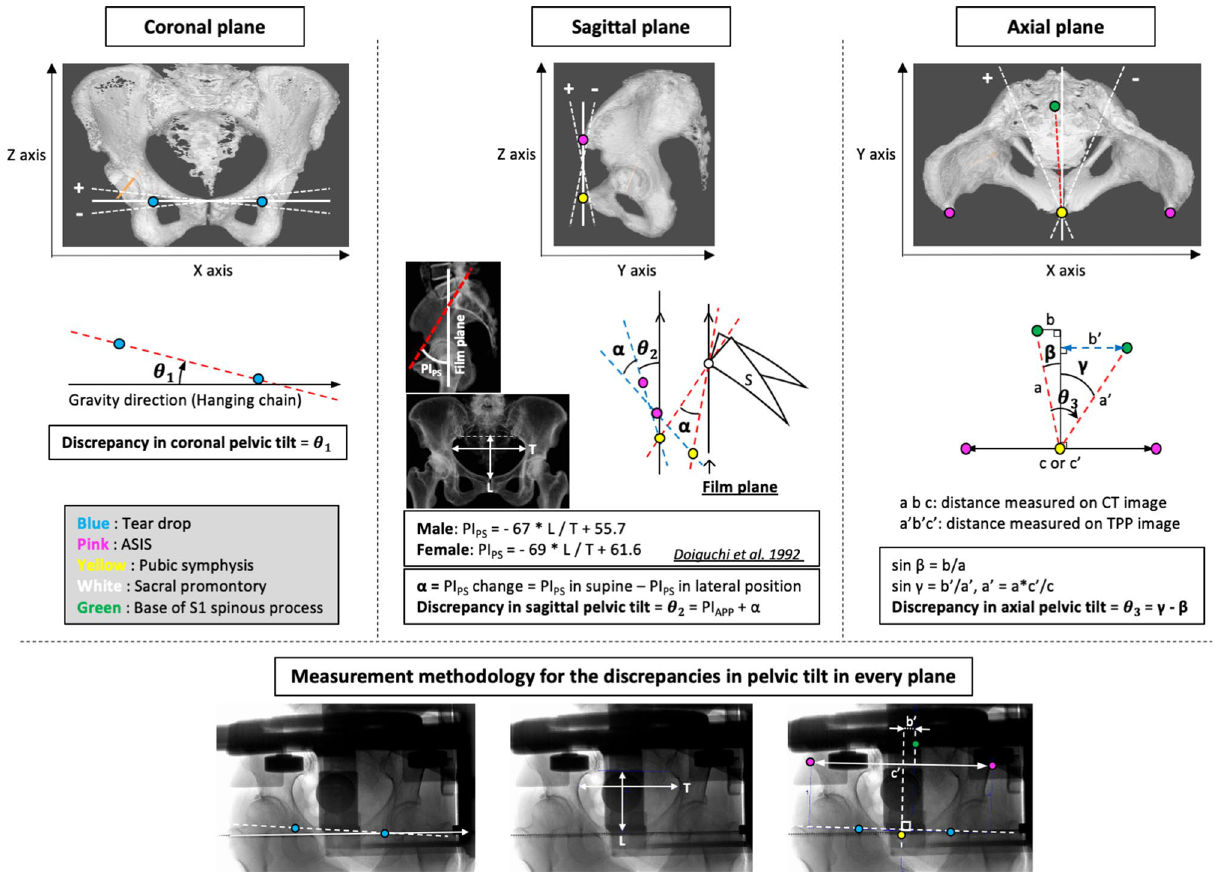
Figure 1. Measurement methodology for the discrepancies in pelvic tilt in every plane. When the operative side was on the right, the leftward inclination in the coronal plane, the forward tilt in the sagittal plane, and the anterior rotation in the axial plane were defined as positive. ASIS, anterior superior iliac spine; S, sacrum; PI PS , pelvic inclination of plane formed by pubic symphysis and sacral promontory; PI APP, pelvic inclination of anatomic pelvic plane in supine position; CT, computed tomography; TPP, table parallel